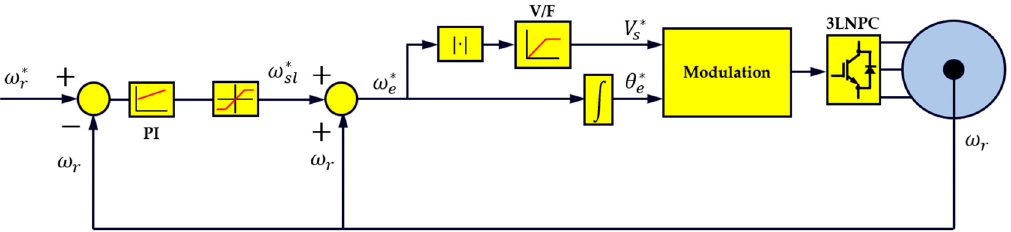
Figure 5. V / F with speed control Figure 5. V/F with speed control scheme.